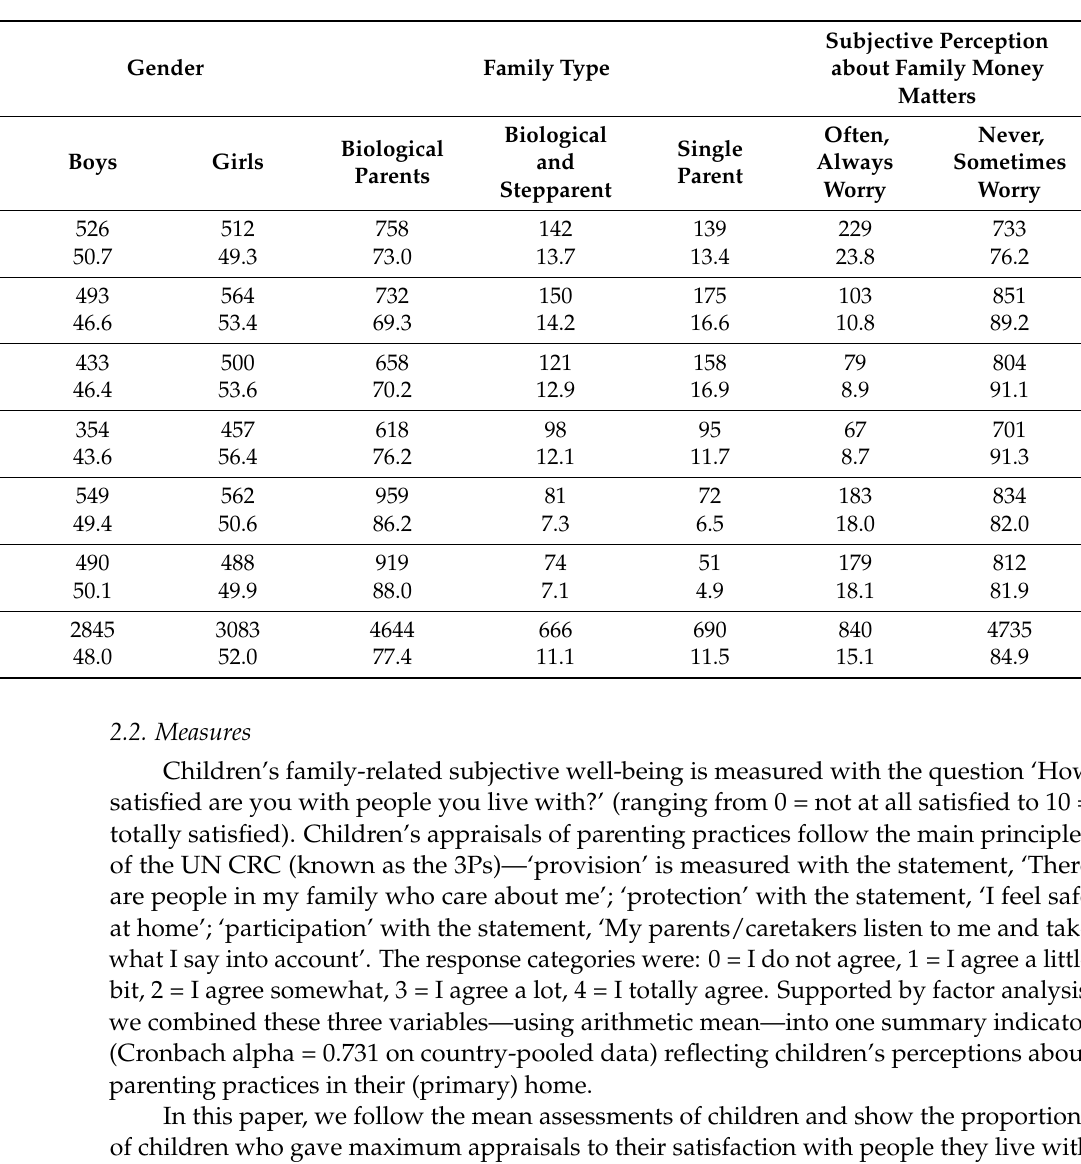
Table 1. Number and proportion of children in six selected countries by gender, family type, and subjective perception about family money